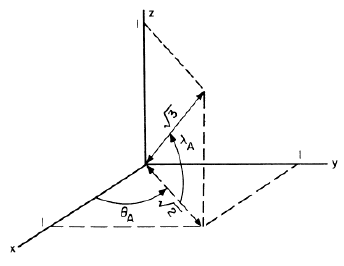
Figure 4. Direction of symmetry axis.